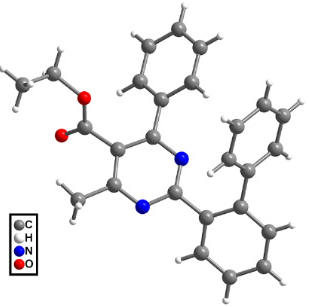
Figure 1. Single crystal X-ray structure of mono-phenylated product 10a (CCDC identification number: 1935971) in ball-and-stick representation.